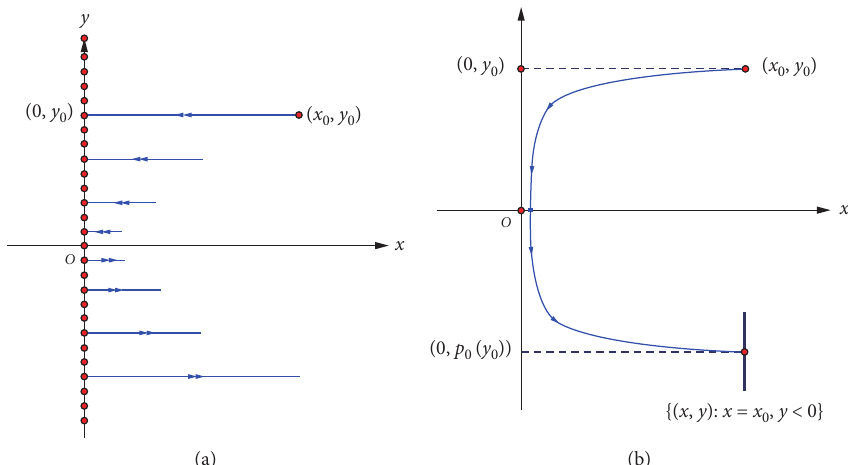
Figure 1: (a) For ε � 0, the orbits of system (4) is shown and the y -axis consists of equilibria. (b) For 0 < ε ≪ 1, a symbolic orbit of system (4) ,y ) and ends at x � x starts at ( x 0 0